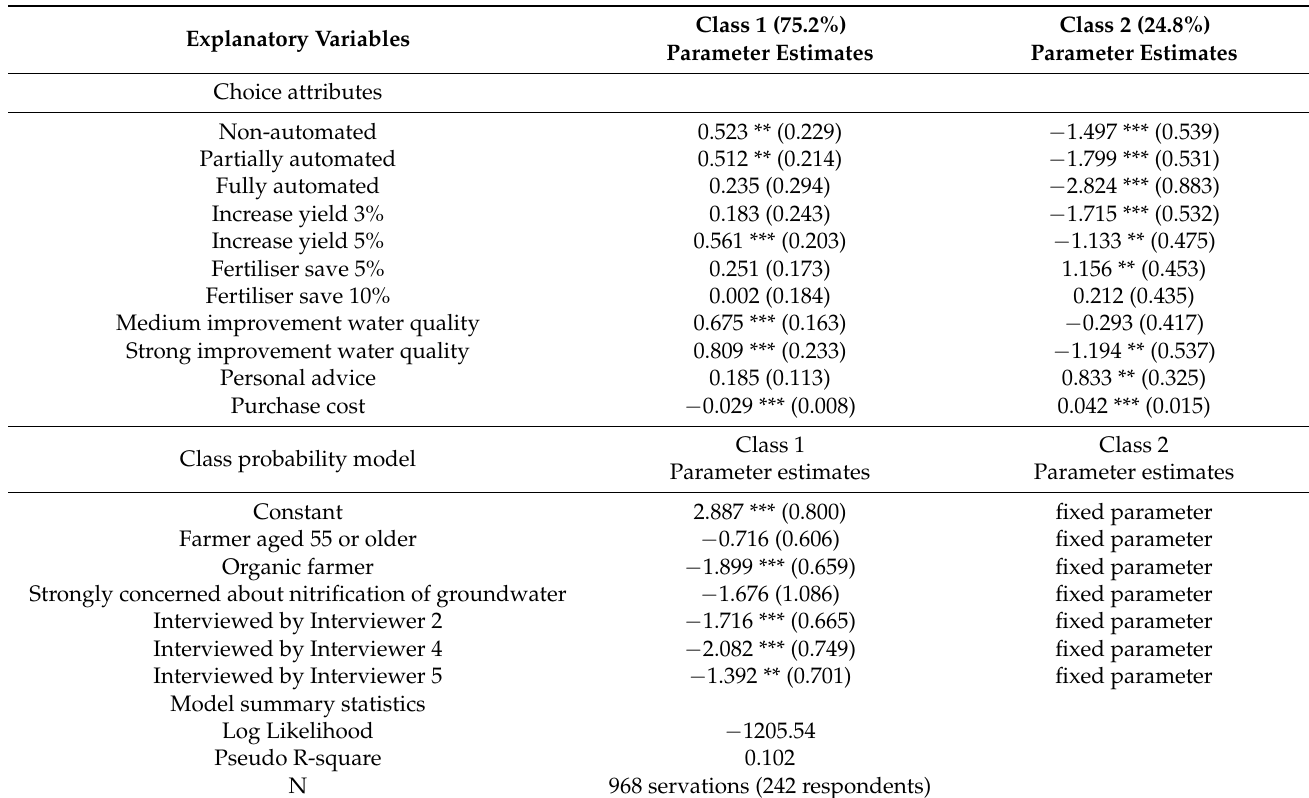
Table 6. Results of the latent class